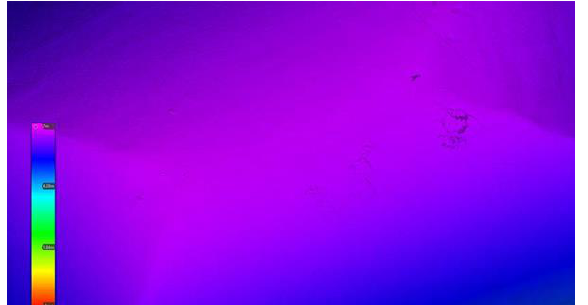
Figura 11. DEM three-dimensional view of the dense cloud: detail of the points where the metal chains have been removed.